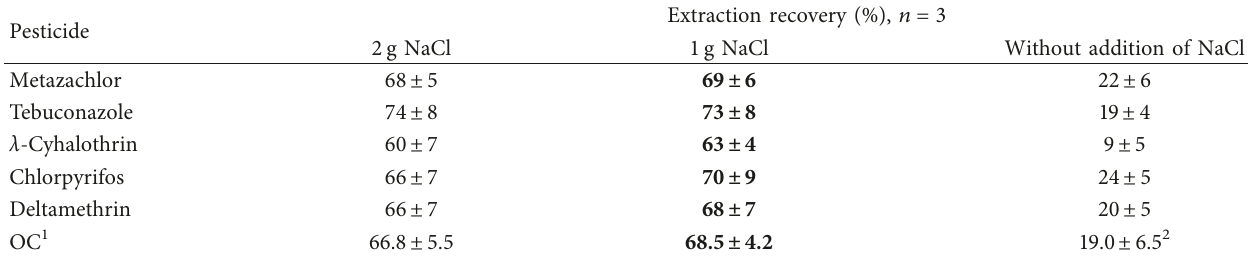
Table 5: Effect of the NaCl amount on extraction efficacy of the five pesticides from rape oil samples. Pesticide